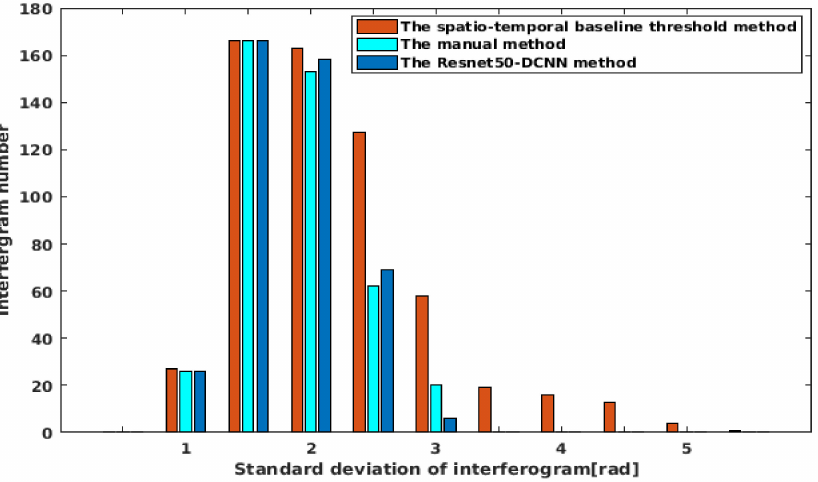
Figure 11. Distribution of the standard deviations of the interferogram phase based on the three different methods displayed in form of a